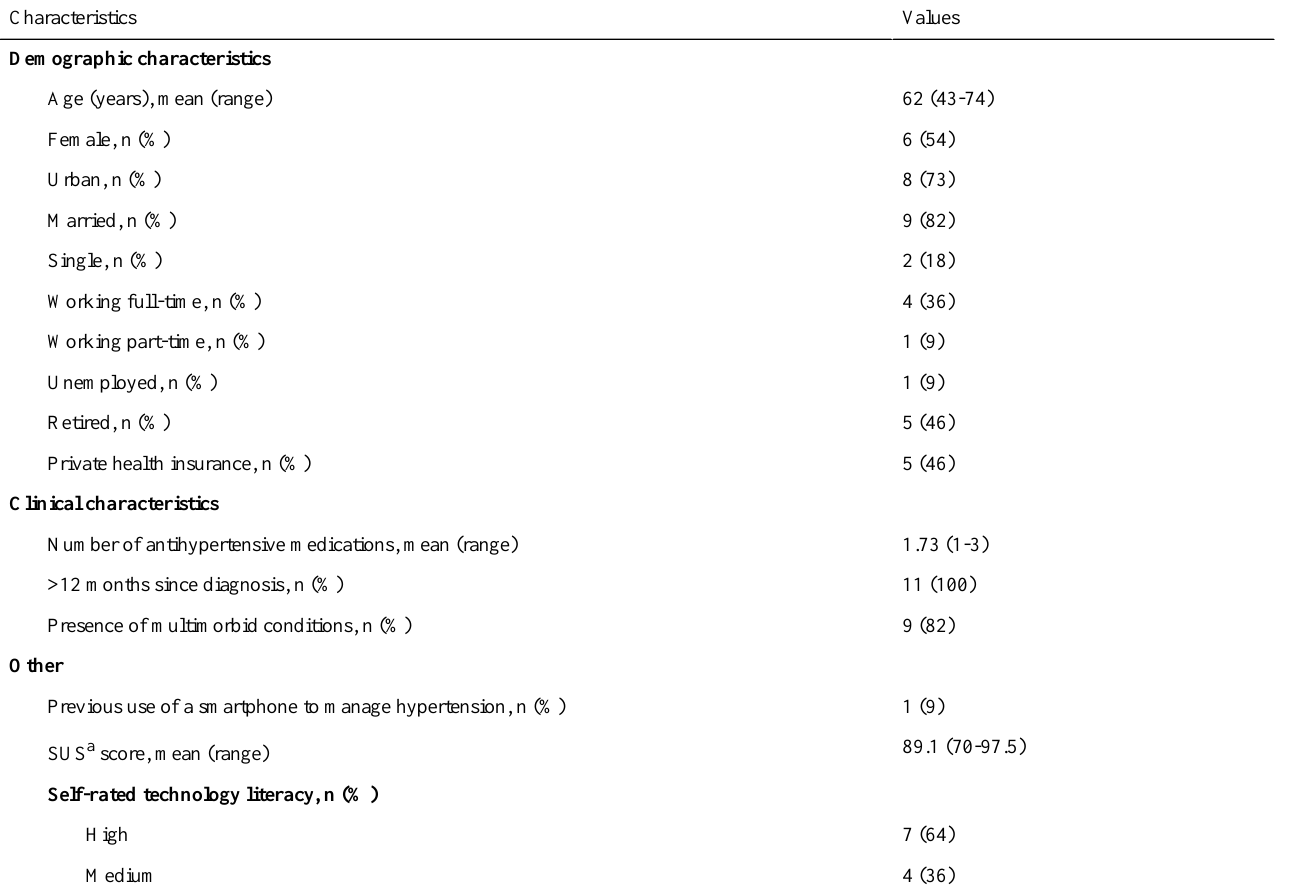
Table 1. Patient characteristics